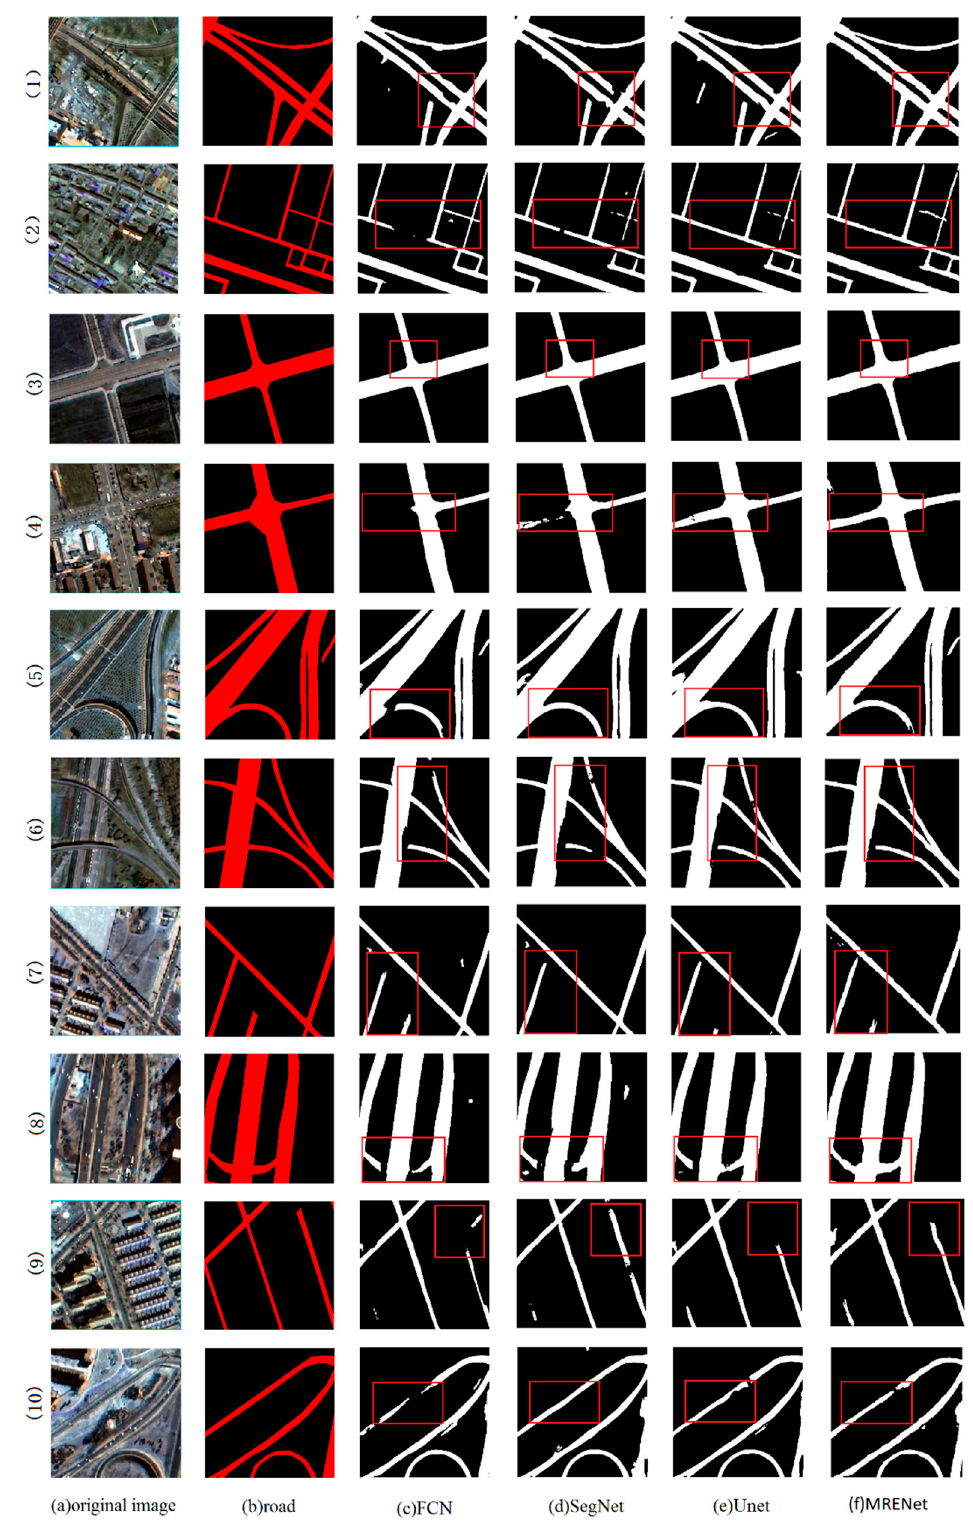
Figure 6. Visual comparisons of road surface extraction results with different